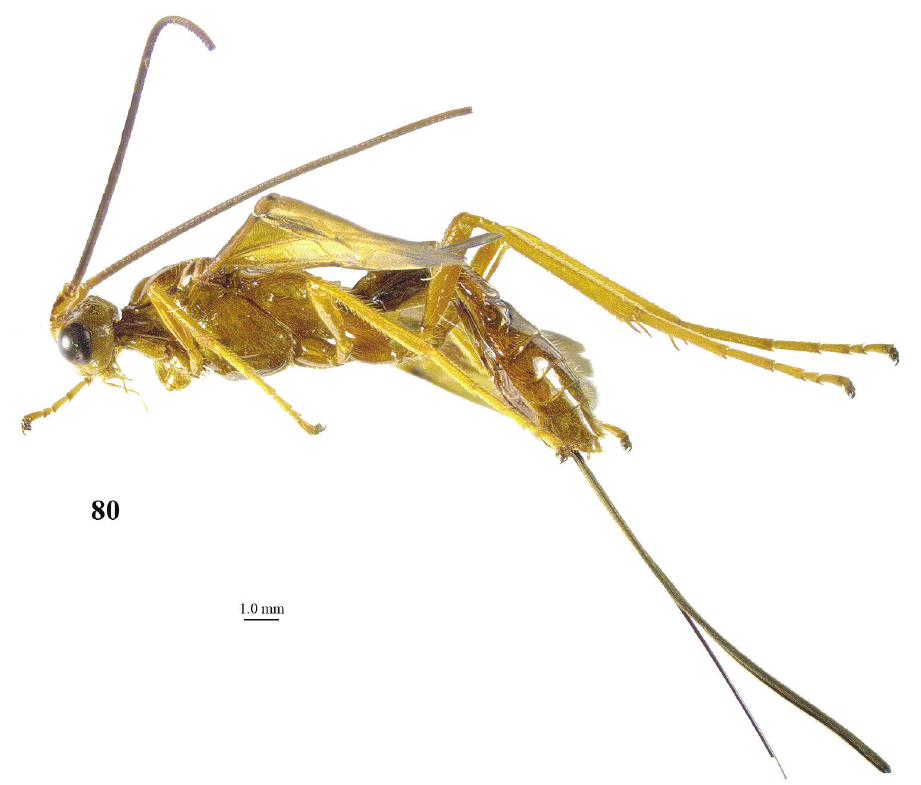
Figure 80. Maculibracon simlaensis (Cameron), ♀ , Vietnam, habitus Distribution. *China (Yunnan). Etymology. Named after the yellow vein 1-SR+M of the fore wing, contrasting with the dark brown surrounding stigmal spot. “Luteus” is Latin for “yellow” and “nervus” for “sinew, vein”.